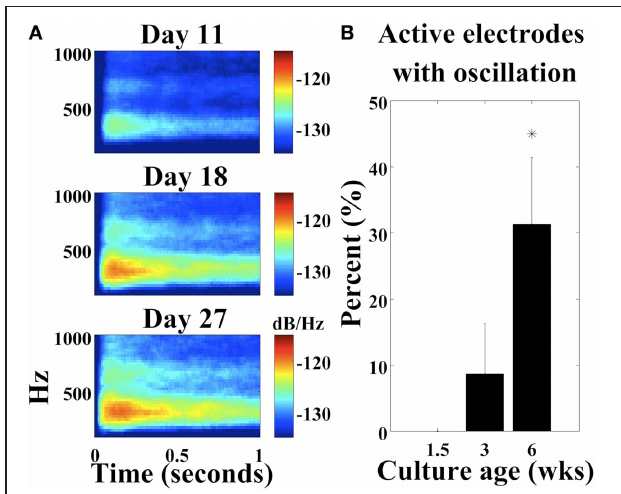
FIGURE 5 | Development of stimulus-induced oscillations. (A) Average power spectrum at 11, 18, and 27 DIV with 0.5V stimulus (large black arrowhead; four cultures) (two cortical and two hippocampal; n = 26 electrodes). (B) The number of active electrodes with the stimulus-evoked oscillation increases as cultures age. ( ∗ p < 0 . 001; n = 7 cultures; median total active electrodes per culture = 59). 1 μ M TTX was present in the medium. Error bars: standard